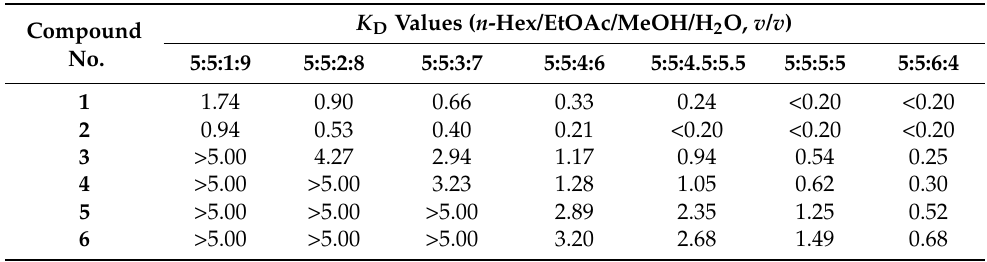
Table 1. The K D values of target compounds in HSCCC with different solvent